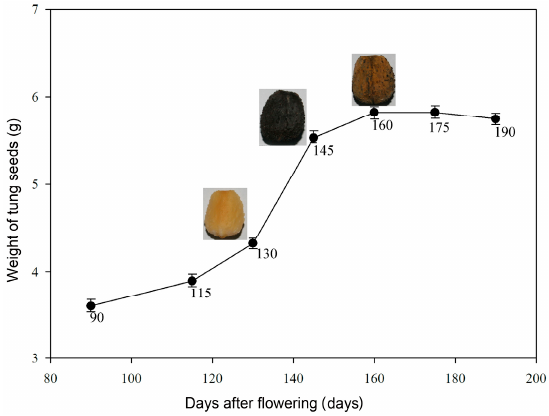
Figure 5. The weight of the tung seeds during development. The x -axis units indicate the number of days after flowering. The y -axis units indicate the average fresh weight (in grams) of six randomly selected seeds.